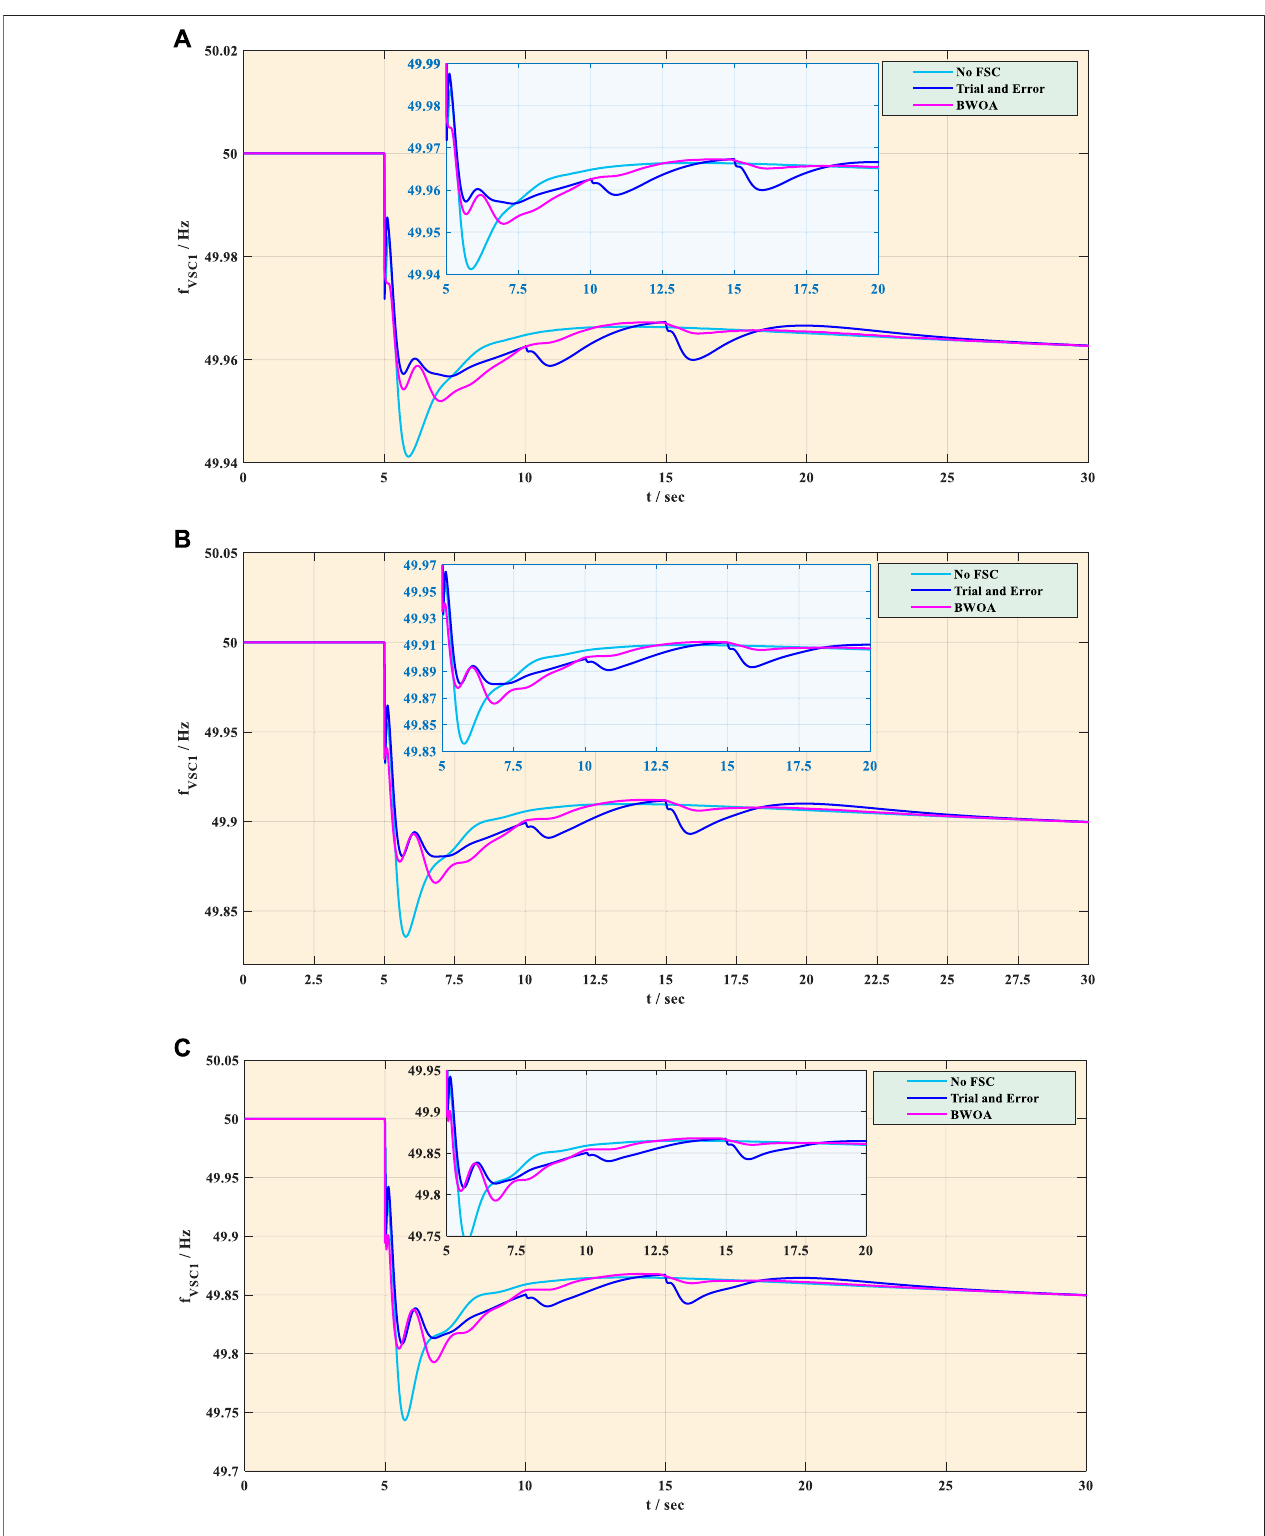
FIGURE 6 | Frequency response acquired by different methods under various load increase variations: (A) 50 MW load increase; (B) 150 MW load increase; (C) 250 MW load increase.